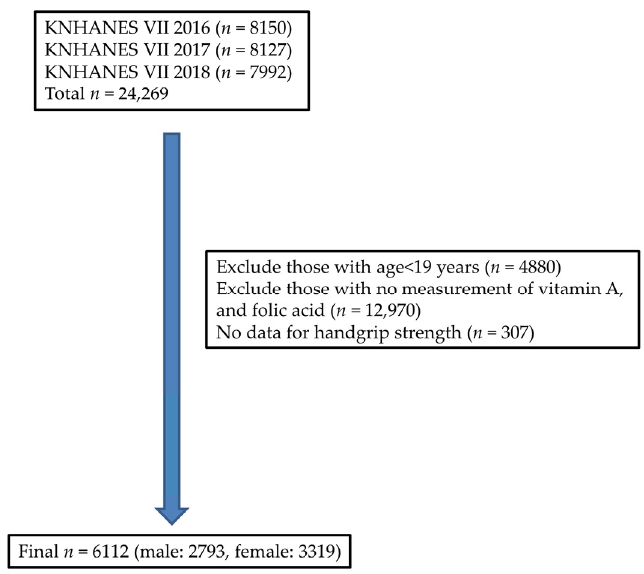
Figure 1. Flow chart shows the number of participants excluded and